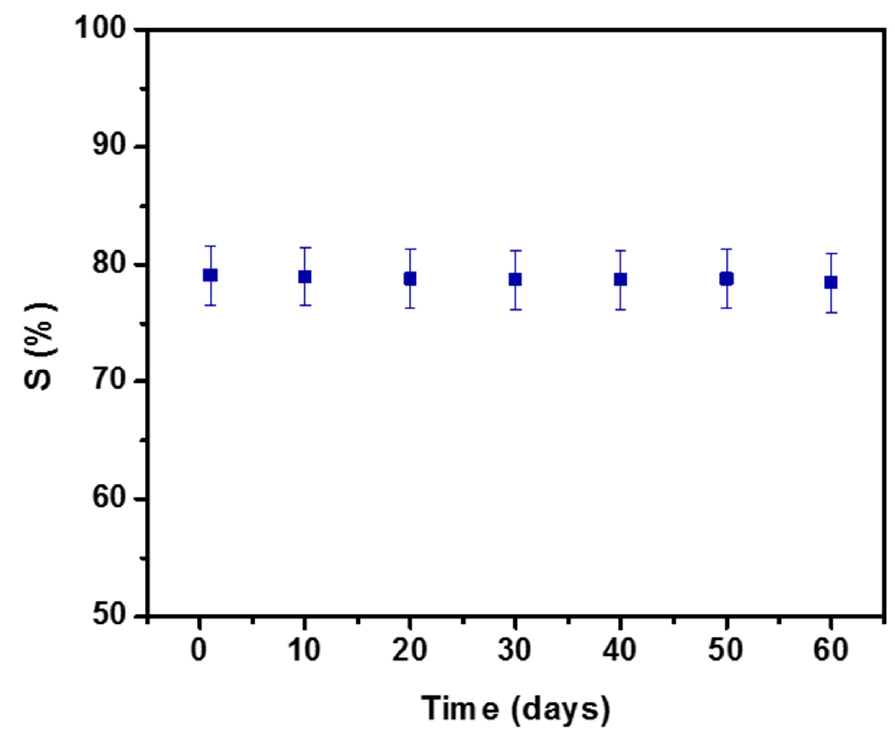
Figure 8. Stability test of the developed MgFe 2 O 4 .